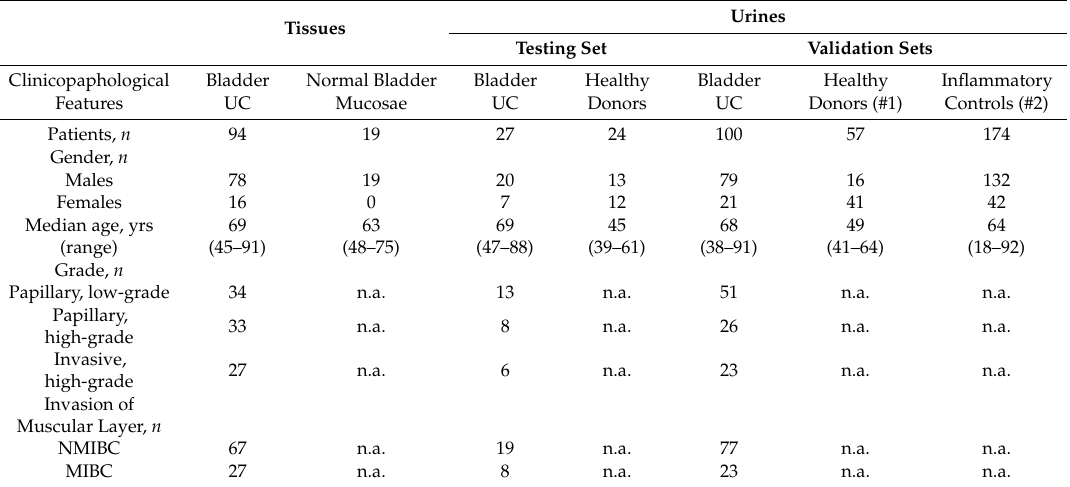
Table 1. Clinical and histopathological characteristics of patients with bladder carcinoma (BlCa), normal bladder mucosae (NB), healthy donors (HD) and inflammatory controls (IC). Urines Tissues Testing Set Validation